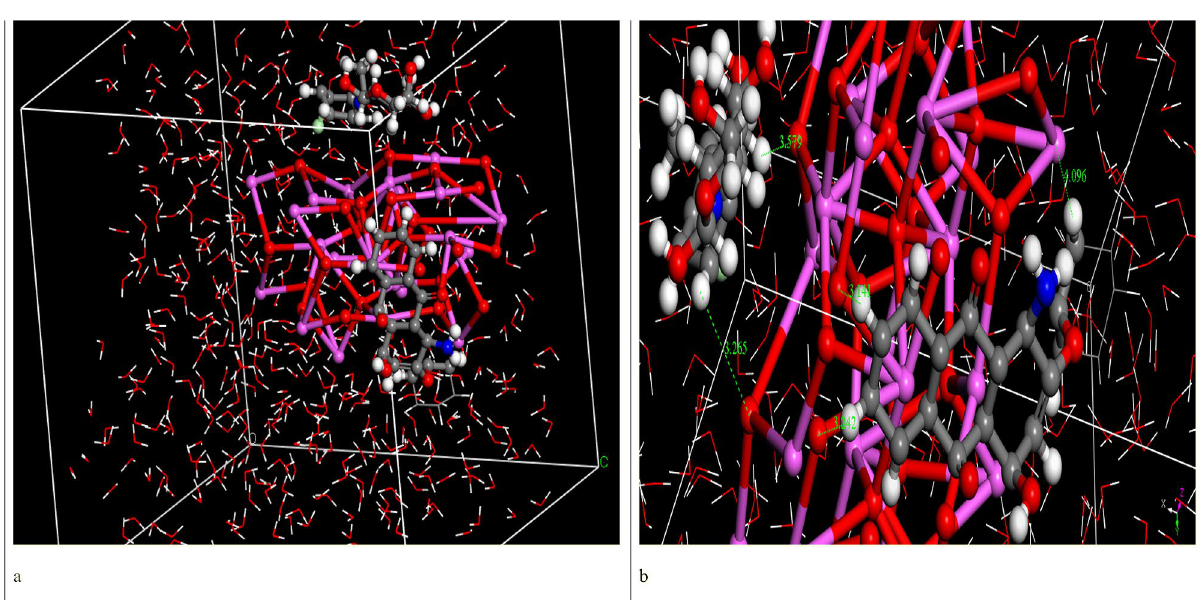
Figure 17. MD snapshots at 10 ns of the adsorption of DR molecule on the CA surface, the bond length is in